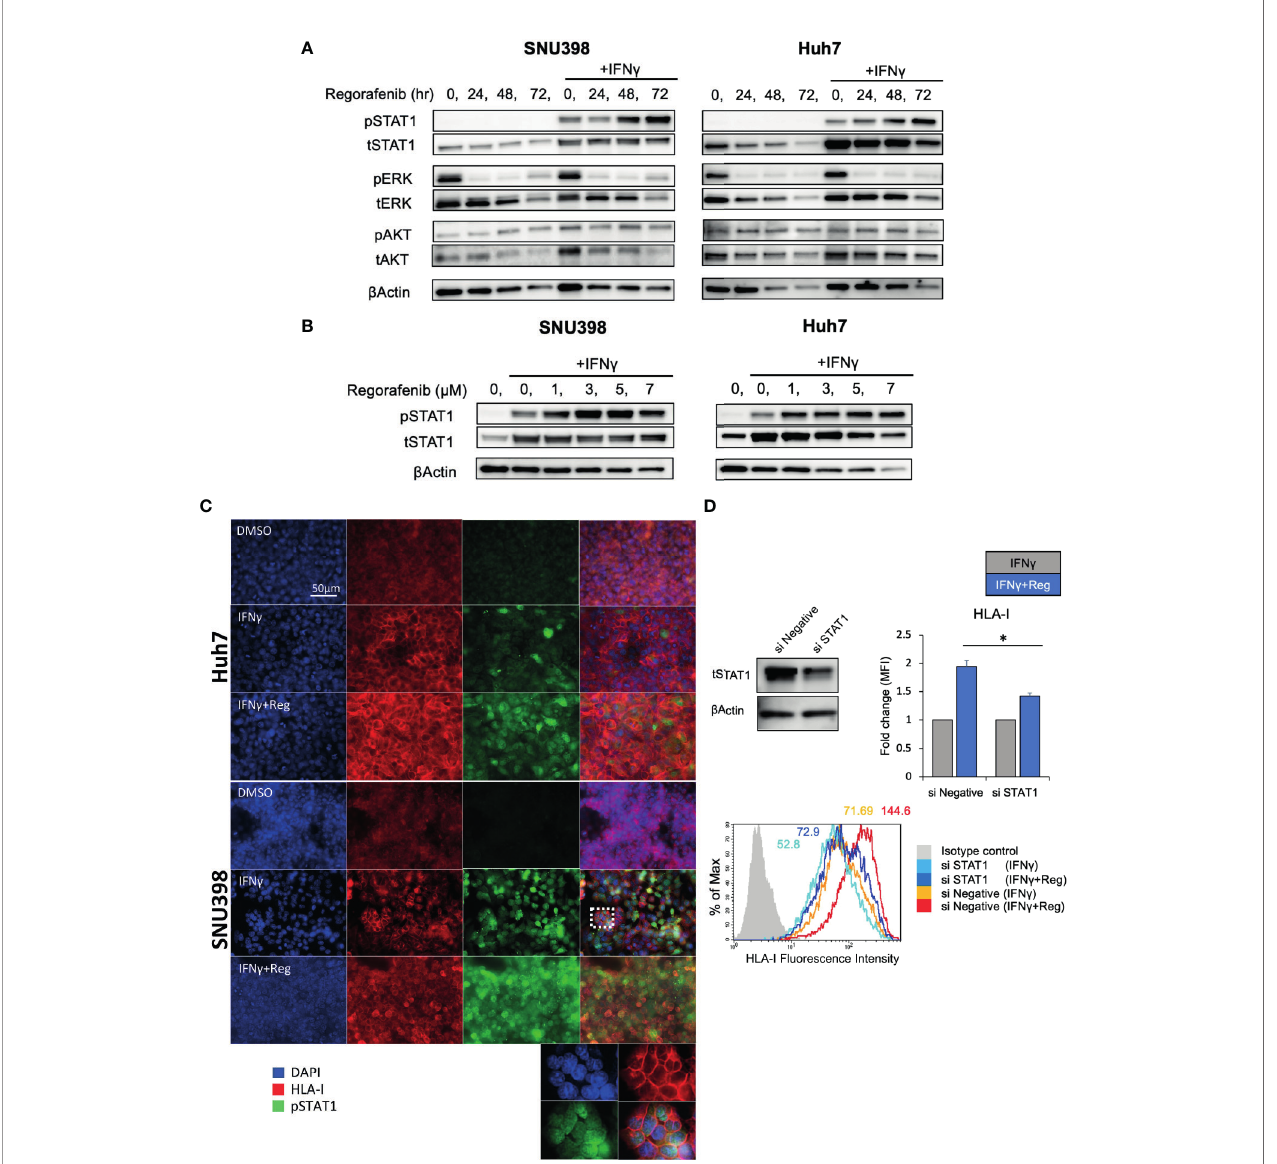
FIGURE 3 | Activation of IFN g /STAT1 signaling is responsible for regorafenib-induced HLA-I expression. (A) SNU398 or Huh7 cells were stimulated by regorafenib (5 m M) at the indicated times with or without IFN g (1 ng/mL) for 72 hours, and then STAT1, ERK, and AKT protein levels were analyzed by Western blotting. b -actin is used as a loading control. (B) Cells were treated with regorafenib at the indicated concentrations over 72 hours with IFN g . (C) Cells were treated with vehicle, IFN g alone, or IFN g plus regorafenib for 72 hours. Representative pictures of multiple immuno fl uorescence staining show the expression of pSTAT1 (green) and HLA-I (red). Scale bar, 50 m m. (D) SNU398 cells were transfected with STAT1 siRNA or negative control siRNA over 48 hours, and STAT1 protein levels were analyzed by Western blotting. Then, cells were treated with either IFN g alone or IFN g plus regorafenib for 72 hours, and assayed by fl ow cytometry for surface HLA-I expression. Values are expressed as fold change relative to cells treated with IFN g alone. A representative fl ow cytometry histogram is shown. Reg, regorafenib. (*: p <